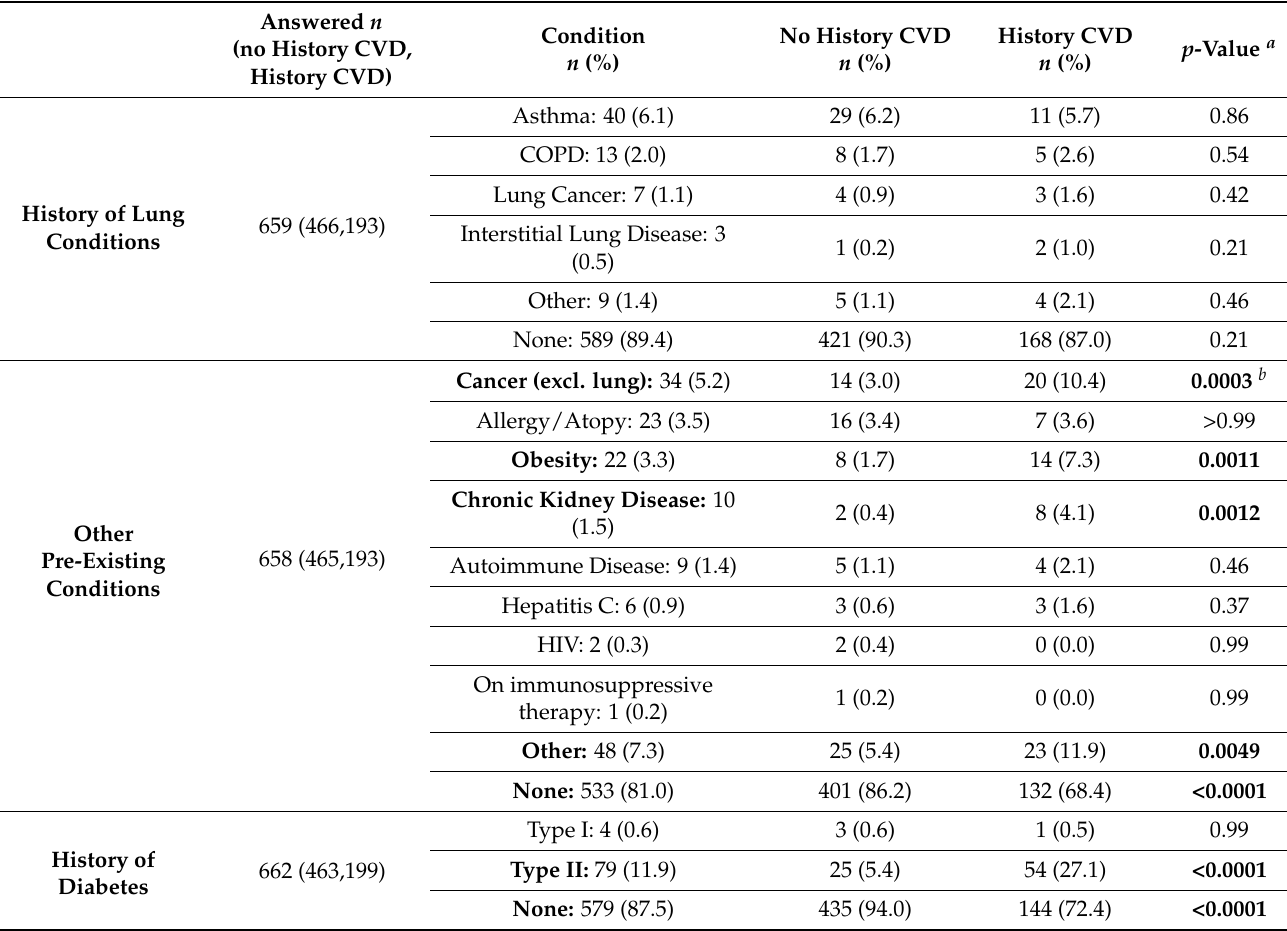
Table 3. History of pre-existing lung and other conditions in registry patients with or without a history of